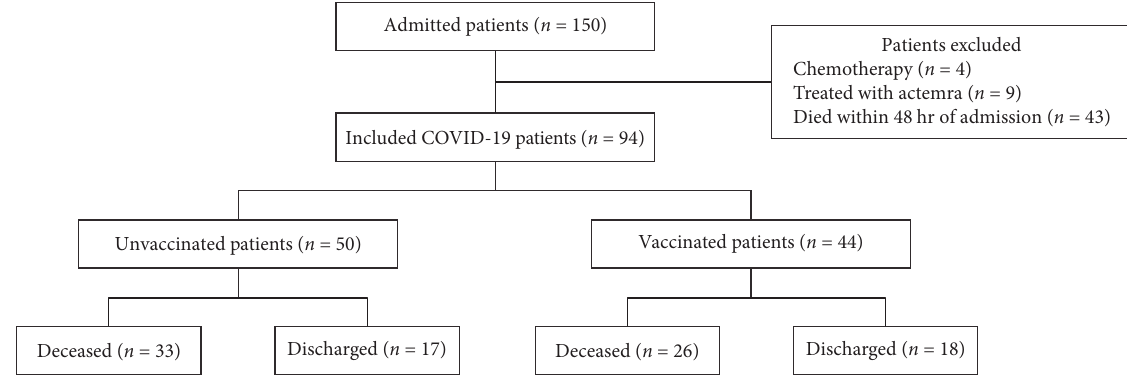
F IGURE 1: Flowchart depicting patient selection and